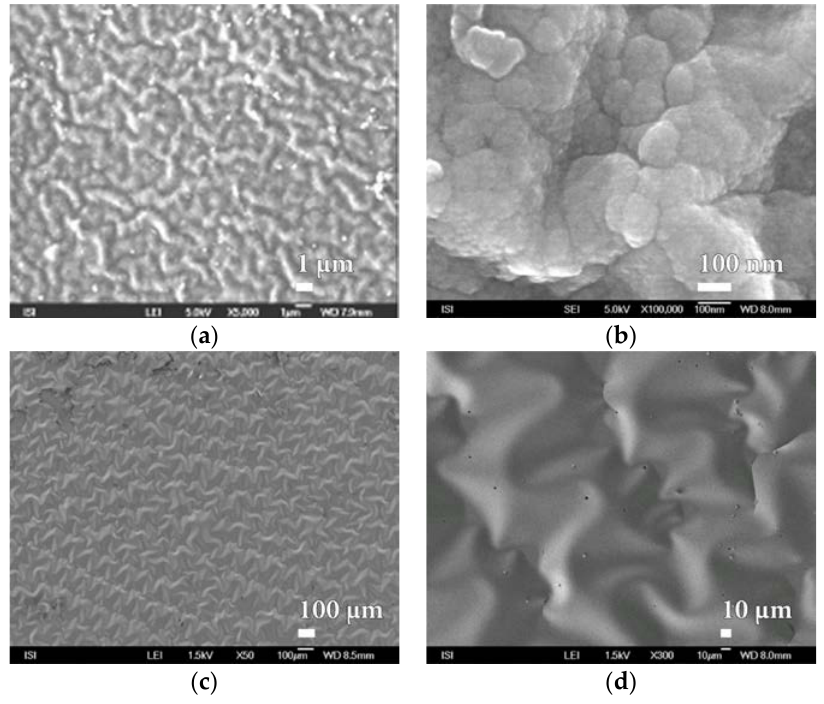
Figure 13. SEM micrographs of SiO x barrier nanocoating surface prepared by the plasma deposition by HMDSO method on PEVA foil at magnification of ( a ) 5000× and ( b ) 100,000× and on PEVA foil stained with aluminium at magnification of ( c ) 50× and ( d ) 300×.